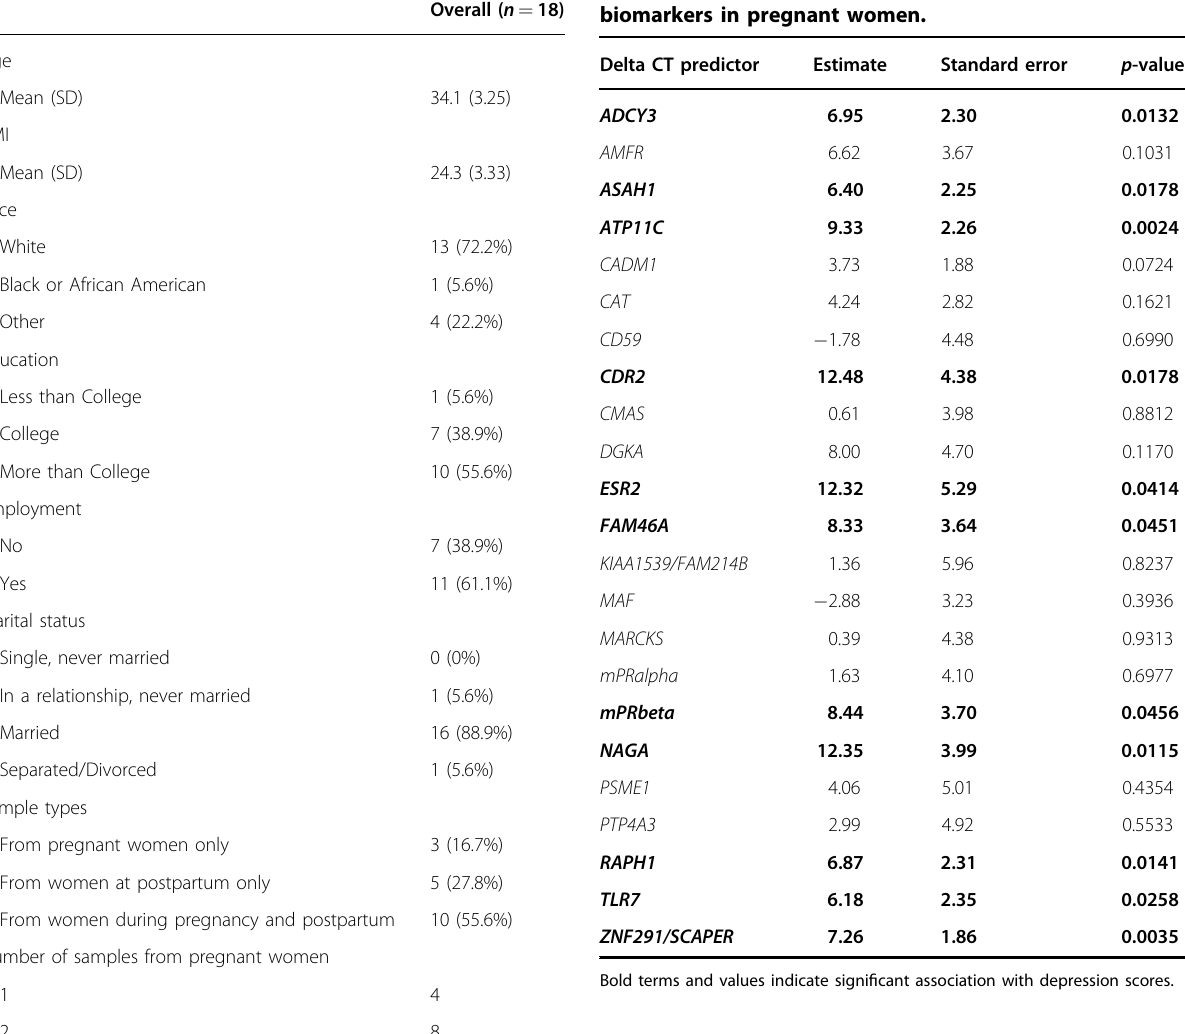
Table 1 Sociodemographic characteristics of subjects. Table 2 Mixed effect models to evaluate association between IDS-SR30 scores and transcript levels of